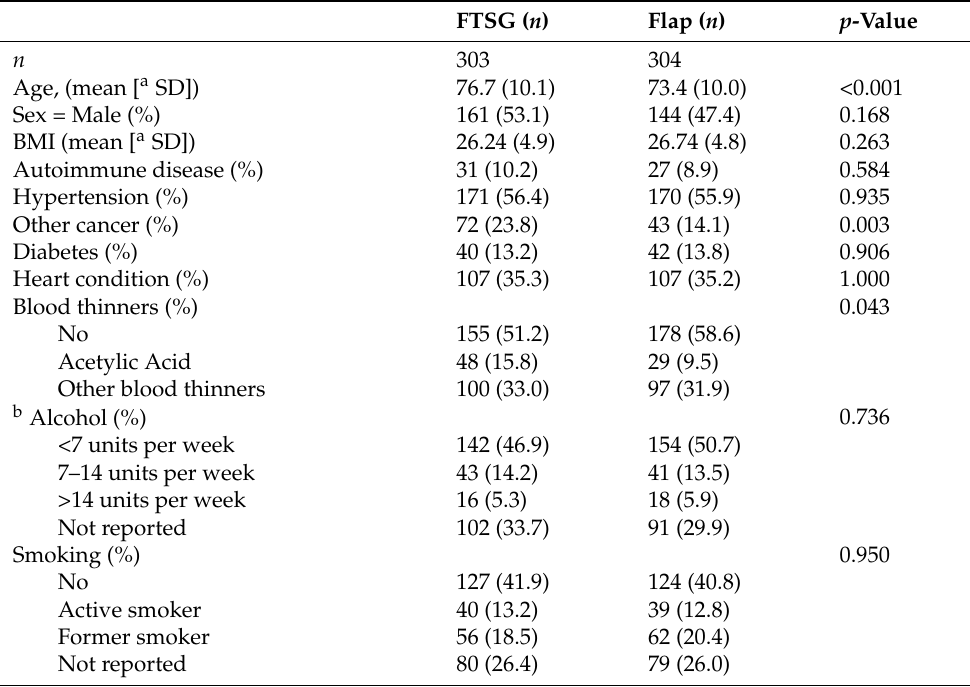
Table 2. Patient demographics and